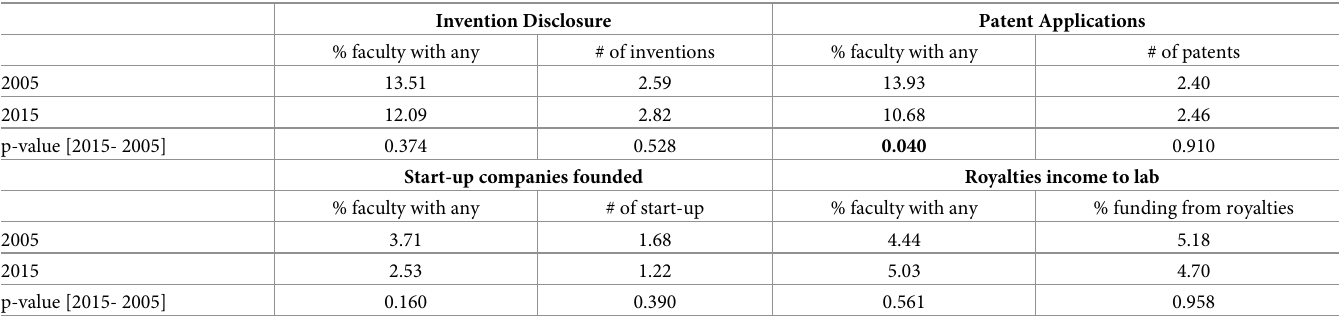
Table 1. Evolution of faculty commercialization